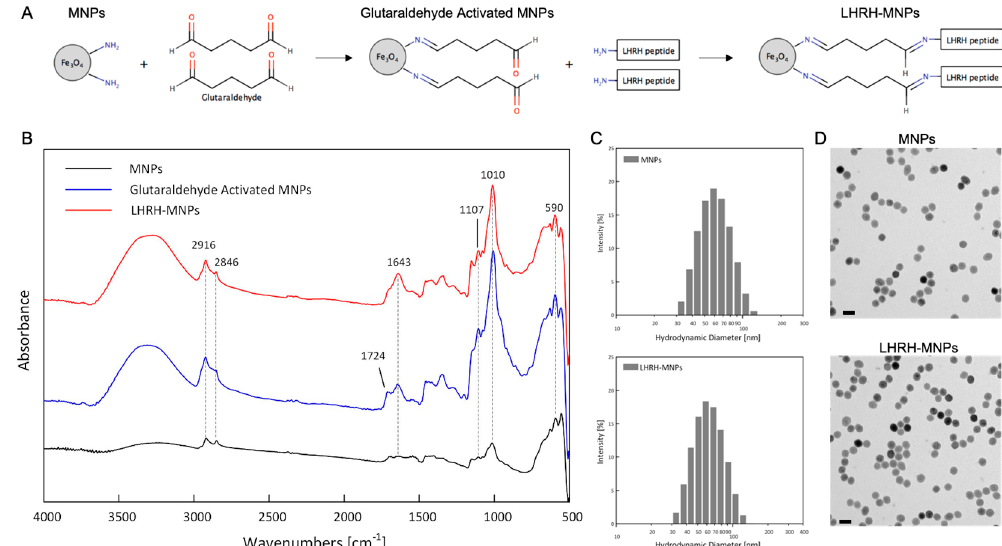
Figure 1. ( A ) Conjugation process of LHRH-MNPs. LHRH peptides were conjugated to the surfaces of MNPs via glutaraldehyde crosslinking chemistry to generate LHRH-MNPs. ( B ) Fourier-transform infrared spectroscopy (FTIR) spectra of MNPs, glutaraldehyde activated MNPs and LHRH-MNPs, showing successful conjugation. ( C ) Hydrodynamic diameter distribution of MNPs and LHRH-MNPs, as measured by dynamic light scanning (DLS). ( D ) Transmission electron microscopy (TEM) micrographs of MNPs and LHRH-MNPs. Scale bars are 100 µm. [25].